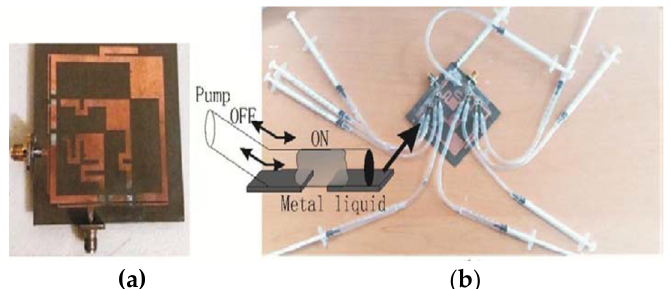
Figure 7. ( a ) Prototype fabricated filter; ( b ) setup of filter presenting a schematic of the metallic switch and a figure of the final setup with syringes used as micropumps [28].